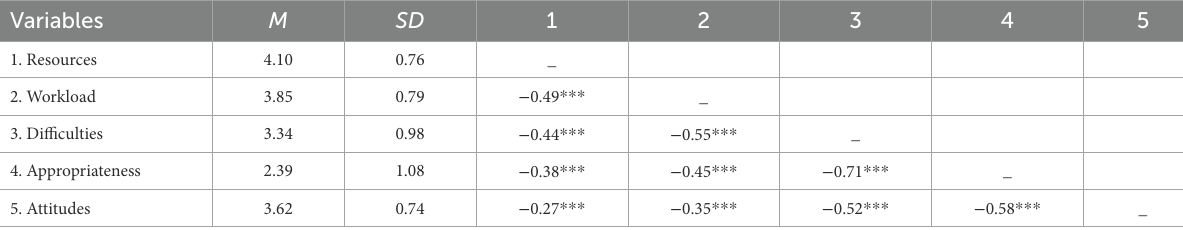
TABLE 2 Descriptive statistics and intercorrelations between variables.